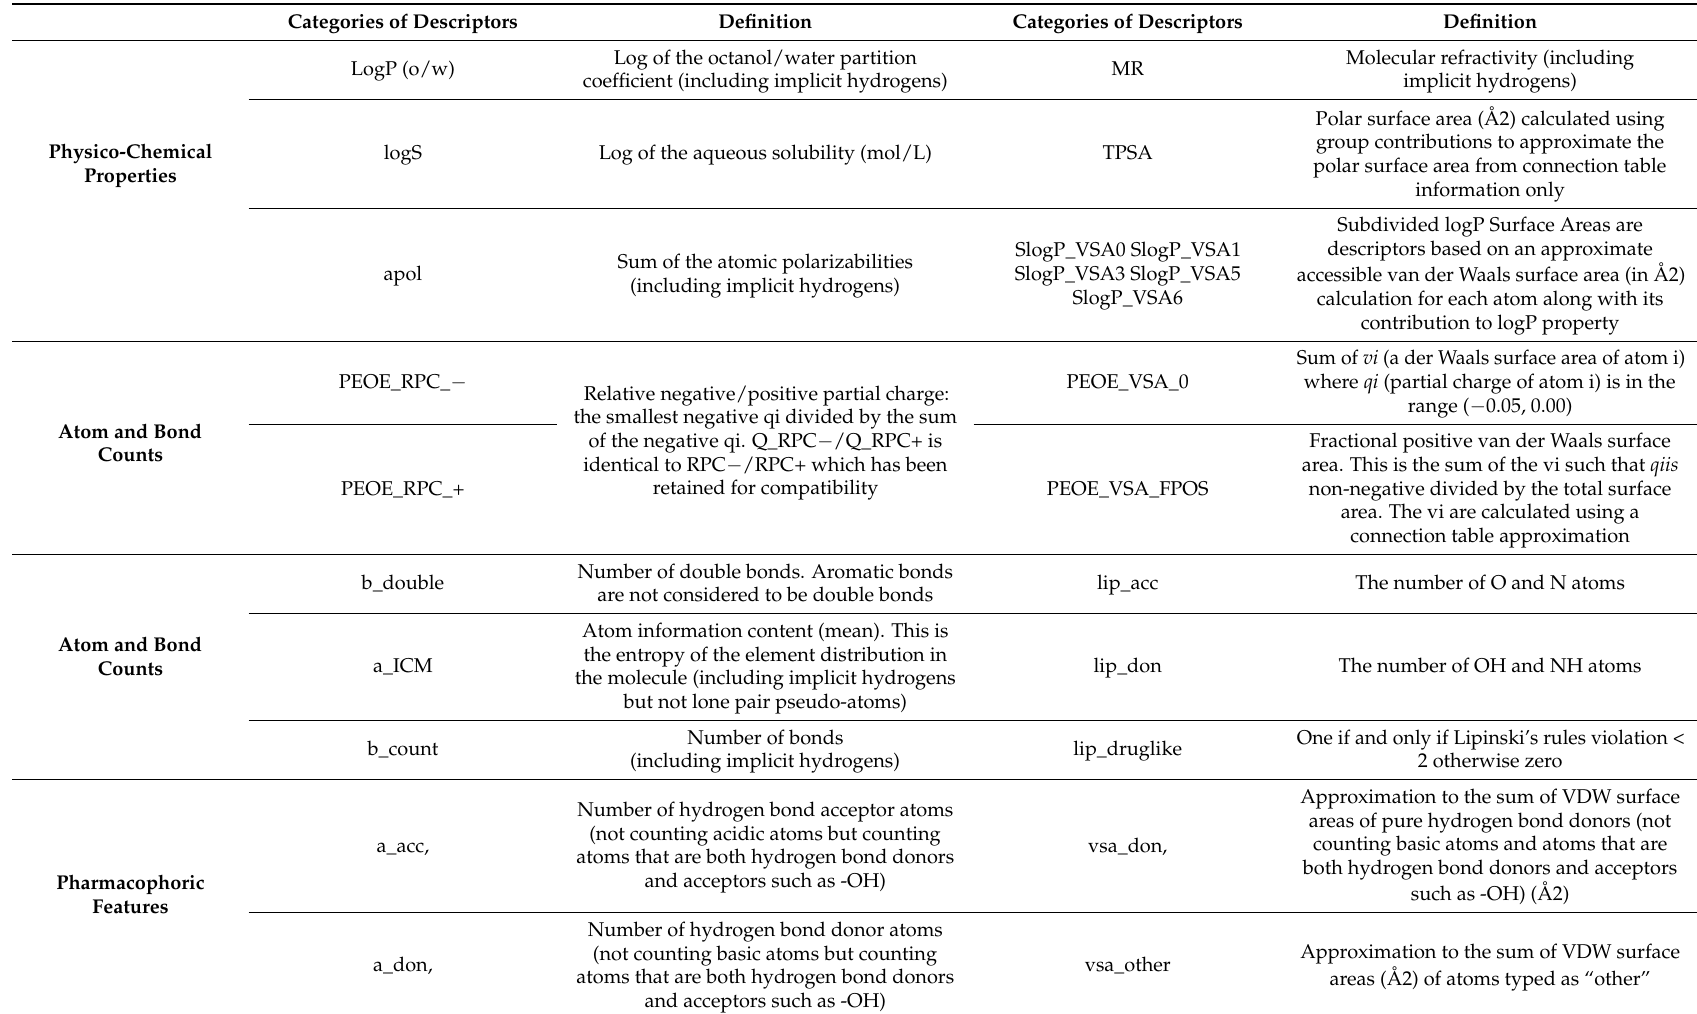
Table 2. Categories and definitions of computed molecular descriptors